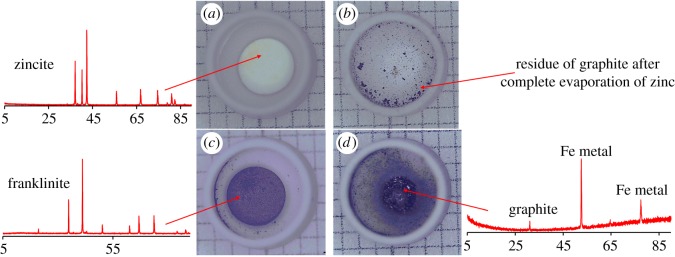
Experiment crucible after TG-DSC. (a) Raw ZnO; (b) ZnO with reducing agent; (c) Raw ZnFe2O4; (d) ZnFe2O4 with reducing agent.